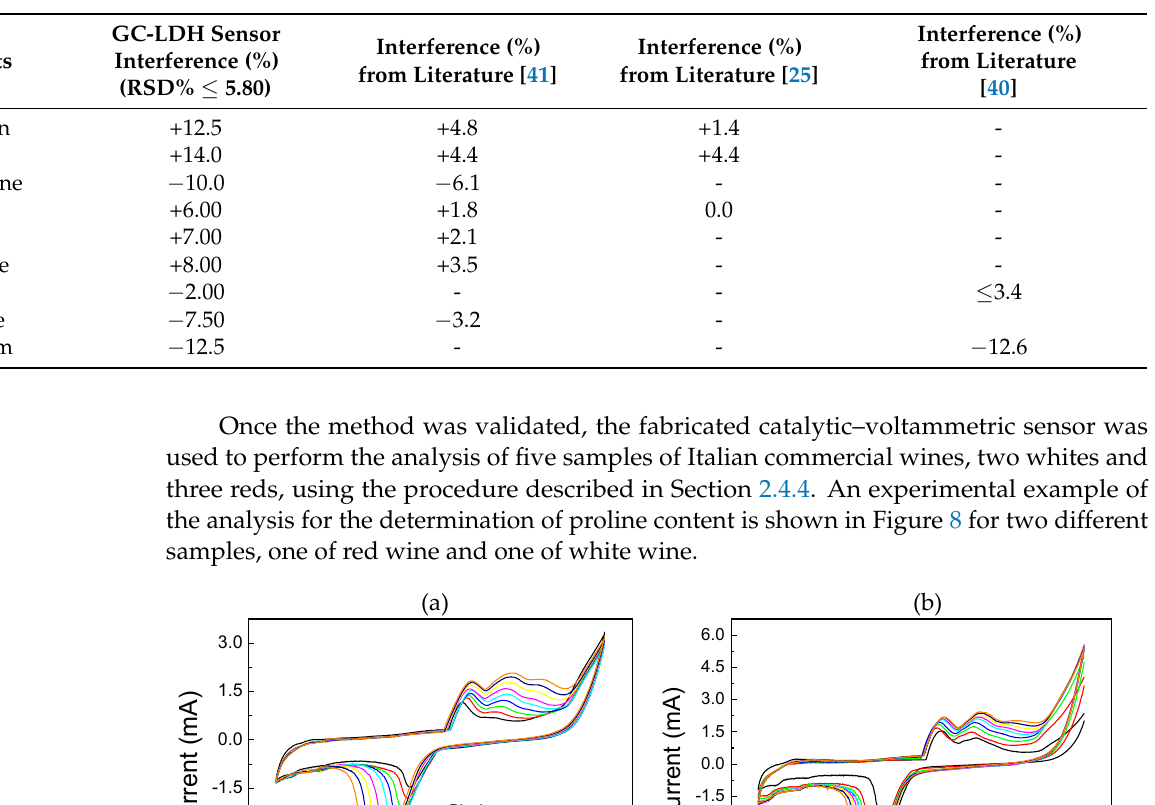
Table 3. Interferences in proline determination, expressed as the percentage response variation to proline, using the catalytic GC-Ag (paste) -LDH- H 2 O 2 voltammetric sensor, to several possible amino acids contained in wines and to ammonium ion. Each added interfering species had a final concentration in solution equal to that of proline, i.e., 0.1 mol L − 1 (the reported values are the mean of three determinations). Results from this work are compared with those reported in the literature for the same interfering species.